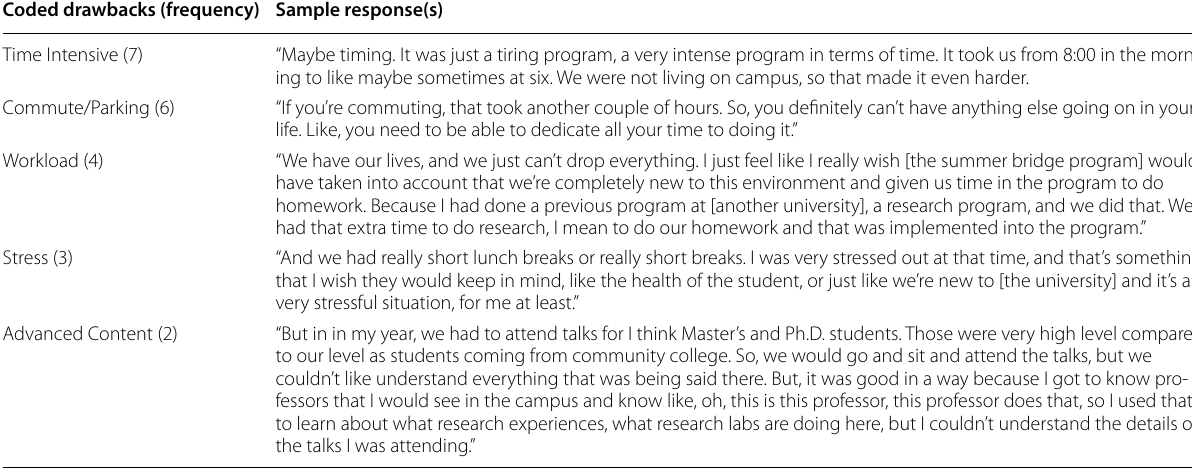
Table 5 Drawbacks of participating in the summer bridge program. Coded drawbacks are in order from highest to lowest frequency, and sample responses are provided for each code. Seventeen out of 29 participants did not articulate any drawbacks. Some of the other twelve participants described multiple drawbacks, resulting in a total of 22 coded segments Coded drawbacks (frequency) Sample